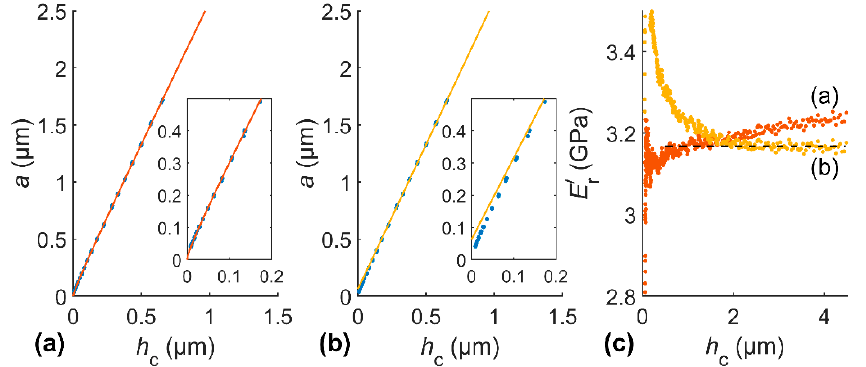
Figure 7. Indenter shape function ( a ) a = C 1 h c + C 2 h 1/2 c , fitted to the entire contact depth range of fused silica data, ( b ) a = C 3 h c , fitted to the range above 200 nm, and ( c ) reduced storage modulus versus contact depth of polycarbonate obtained using the respective shape functions in corresponding colors, where the dashed line shows the actual modulus of the material.